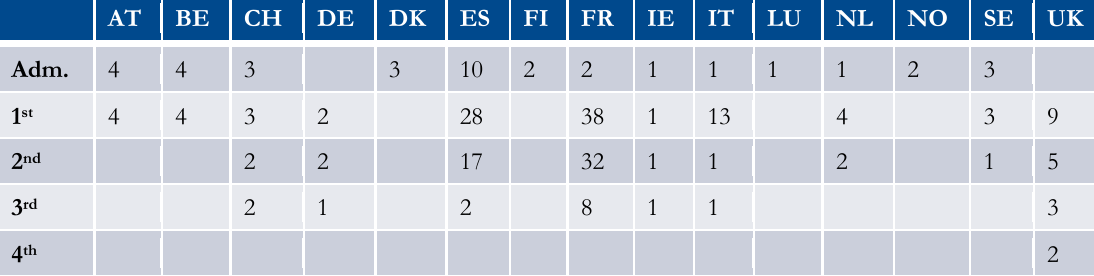
Table 1: European case law on the status of platform workers AT BE CH DE DK ES FI FR IE IT LU NL NO SE UK